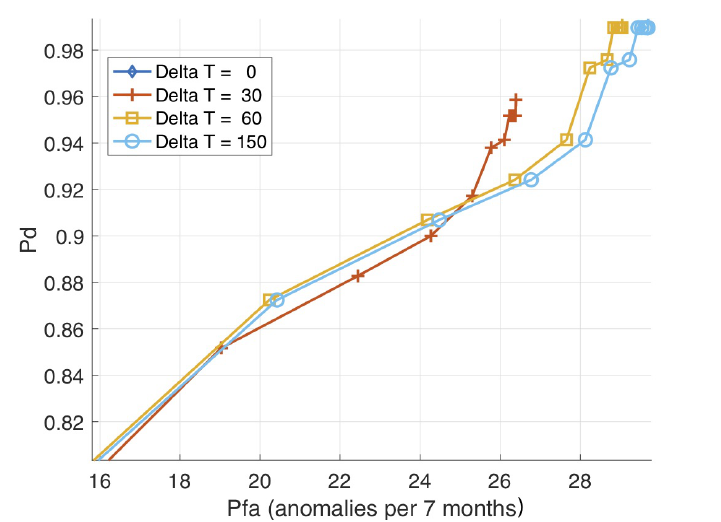
Figure 9. ROC results of majority vote using the spike test as a function of ∆ τ